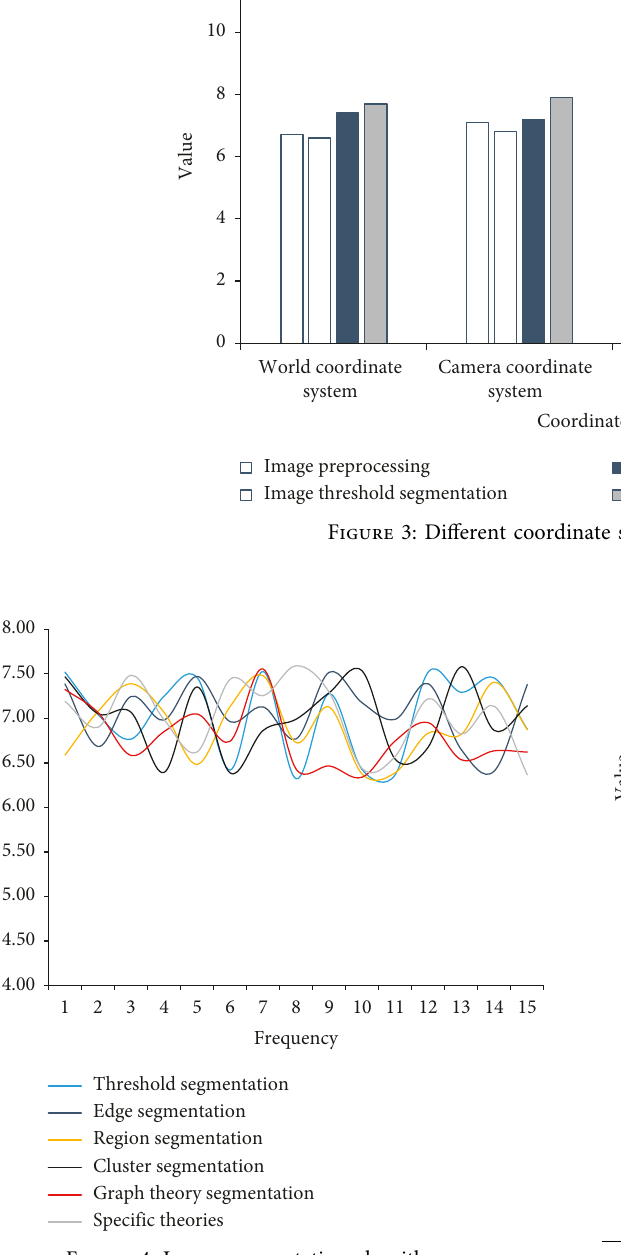
Figure 4: Image segmentation algorithm.